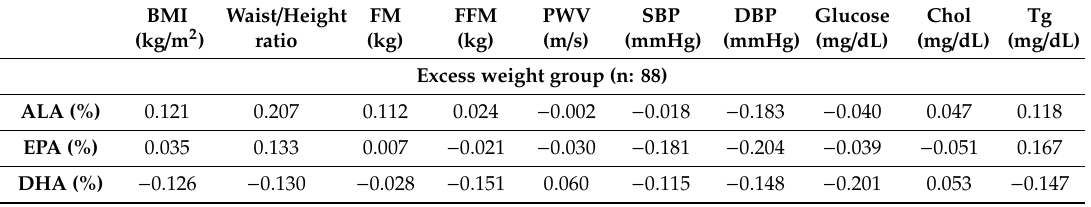
Table 4. Correlations of fatty acids and estimated desaturase activities with anthropometric and clinical characteristics in excess-weight and normal-weight